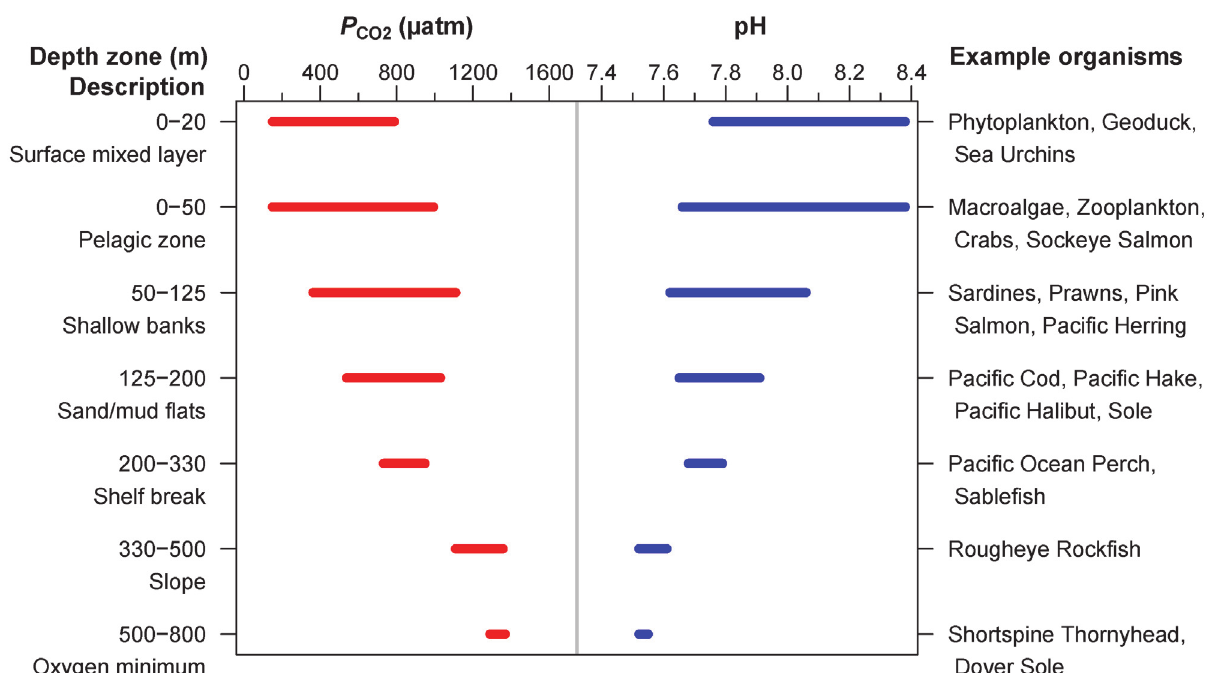
Fig 2. Estimated present-day ranges of P CO2 (red) and pH (blue) during spring [40] and summer [27] for various depth zones along the outer BC continental shelf, with typical species found in each zone (see Methods). There are numerous data above 50m and few below 125 m. The number of values in each depth zone from top to bottom are: 70, 116, 33, 45, 5, 4 and 2, respectively. Above 50 m, the distributions of values are skewed, such that high P CO2 (low pH) extremes occur less often than the low P CO2 (high pH) extremes. Data and R code for this figure are provided as Supporting Information (S2 Code).